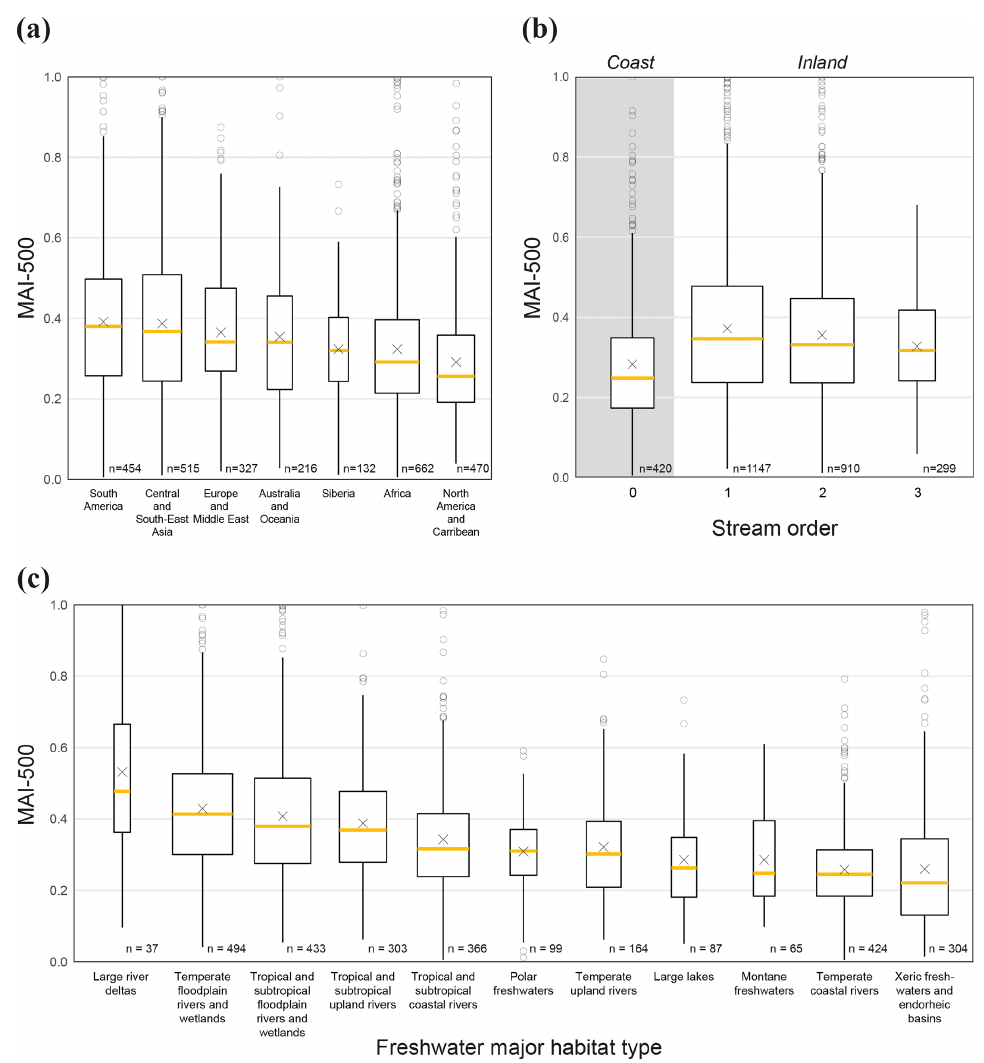
Figure 4. How the model agreement between GFPLAIN, GAR-500, and JRC-500 varies with (a) geographic region, (b) river stream order, and (c) freshwater major habitat type. The model agreement index ranges between 0% (no agreement) and 100% (full agreement) and was calculated here for all the river basins of the world that are covered by all three models. The box hinges correspond to the first and third quartile, and the yellow line corresponds to the second quartile (median value). The mean value is indicated with a cross. The whiskers extend from the box hinges with maximum lengths equal to the inter-quartile range multiplied by a factor of 1.5. Values outside of the whiskers are indicated with dots. The number of river basins corresponding to each group is indicated in numbers and box width. Coastal river basins tend to have lower model agreement scores compared to inland river basins. The freshwater major habitat type specifies the spatially dominating habitat type in each river basin (WWF and TNC, 2019). The habitat type “large river deltas” only includes regions that exhibit both deltaic physical features and deltaic fauna. The habitat type “large lakes” includes river basins that are dominated by large lentic systems. The grouping of basins into geographic regions follows the HydroBASINS